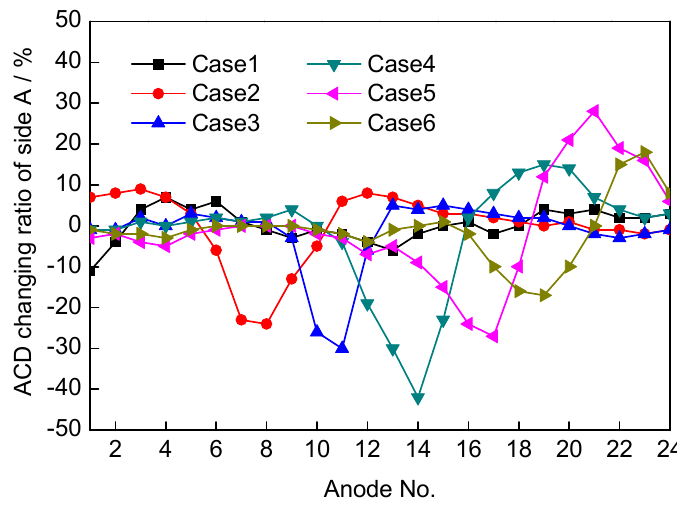
Figure 9. The anode cathode distance (ACD) changing ratios of side A for six abnormal states.